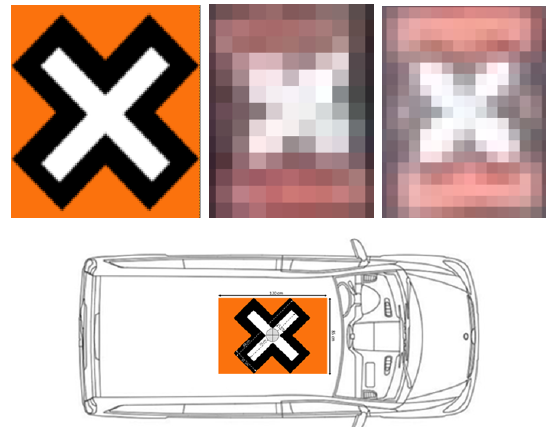
Figure 8. Height differences between vehicle based GNSS measurements (mode A) and DTM heights plus relative vehicle heights at the calibration